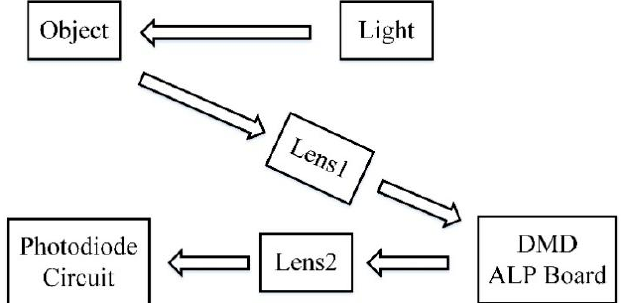
Figure 2. Schematic diagram of single-pixel camera.